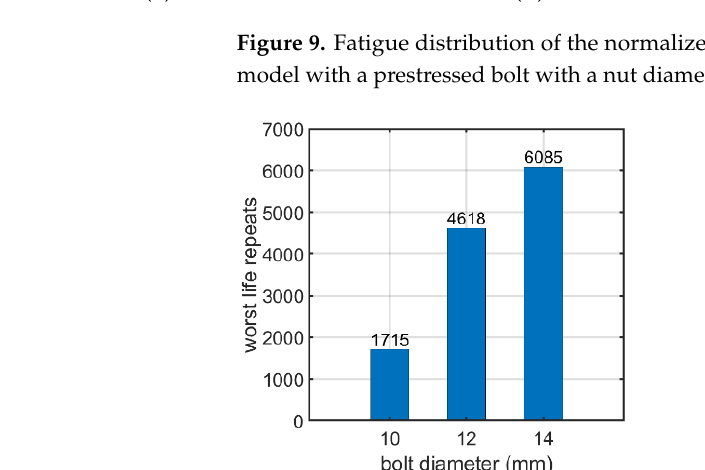
Figure 10. Number of logarithmic life repeats for diameter parameterization of the prestressed bolt with a nut.